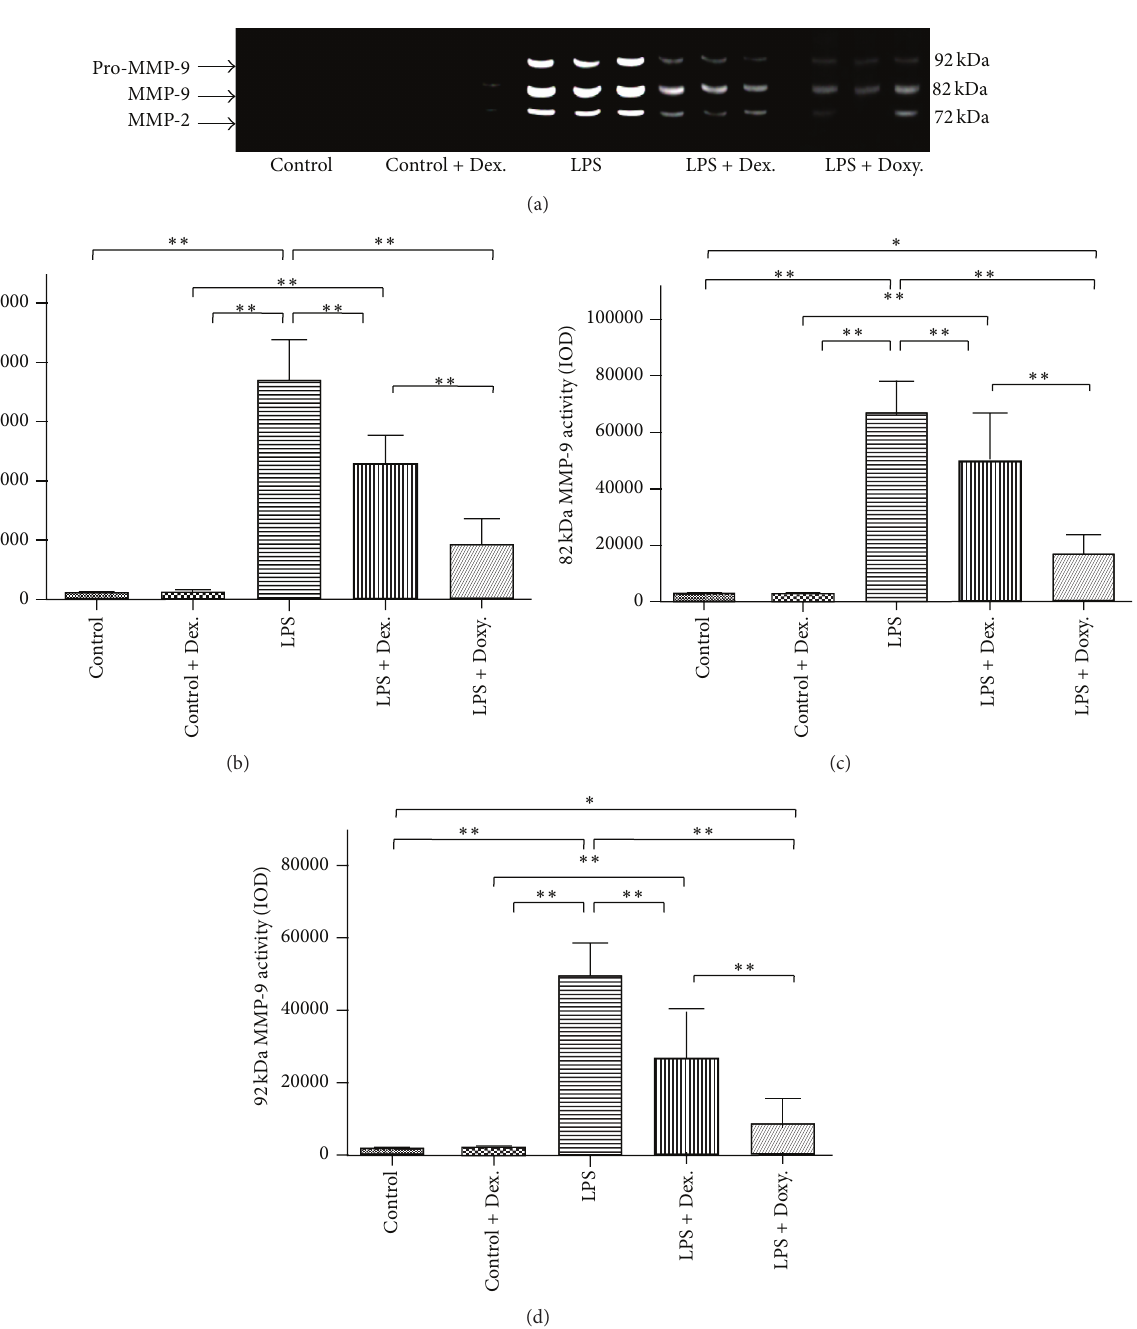
Figure 2: Gelatin zymography. Proteins of the aortic homogenate from each group were used for zymographic assay as described in the method. (a) One representative image data of zymogram. 72-kDa: latent MMP-2; 82-kDa: active MMP-9; and 92-kDa: latent MMP-9. (b, c, and d) Densitometric analysis of 8 biological replicates of latent MMP-2 (72-kDa), active MMP-9 (82-kDa), and latent MMP-9 (92-kDa), respectively. ∗ 𝑝 < 0.05 ; ∗∗ 𝑝 < 0.001